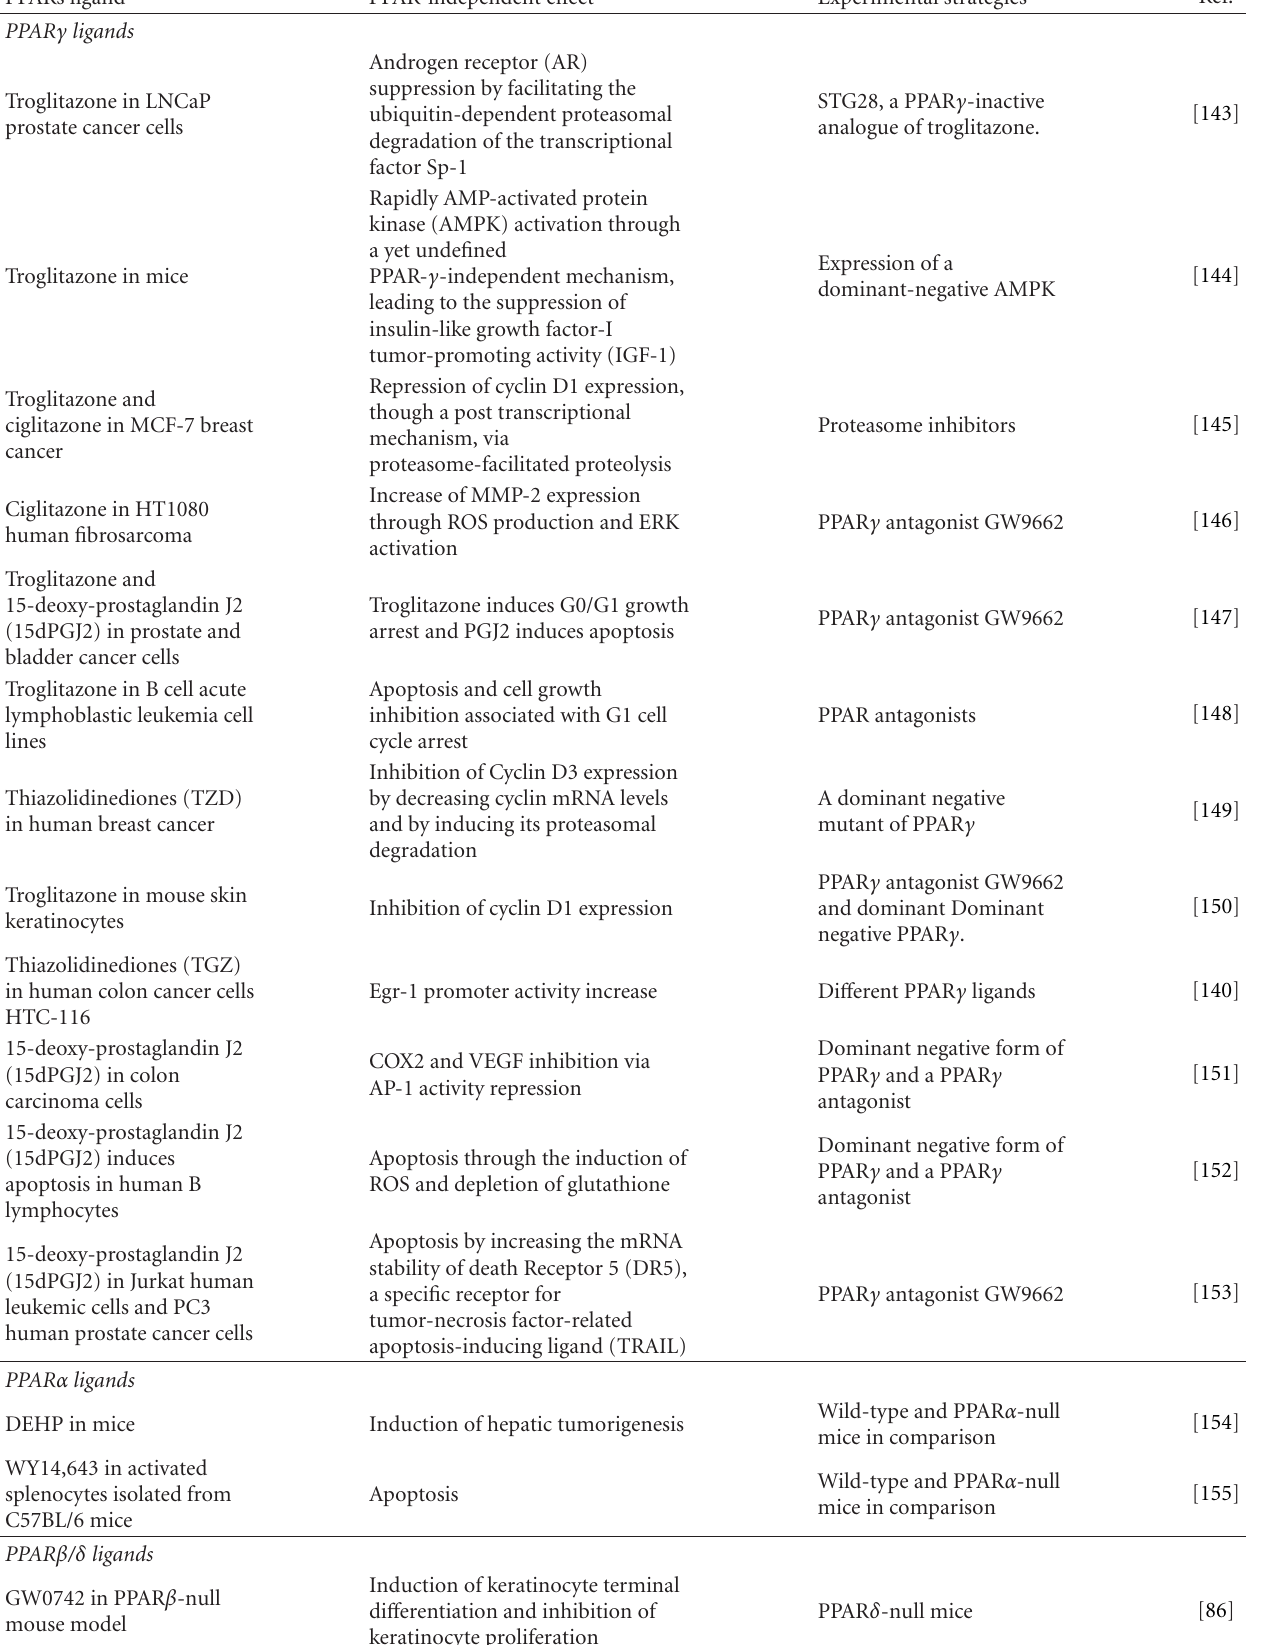
Table 2: PPAR-independent e ff ects on tumor-related genes.